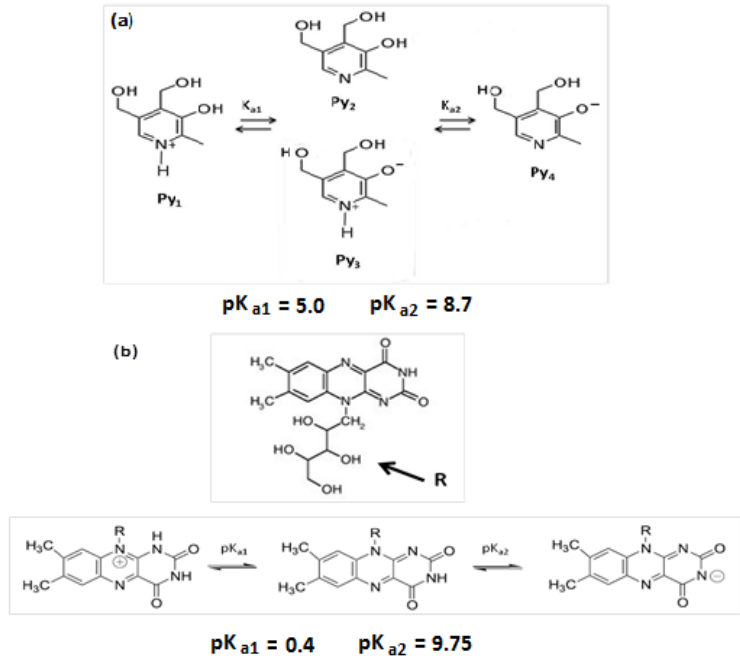
Scheme 1. Structures of pyridoxine ( a ) and riboflavin ( b ) as a function of the solution pH.